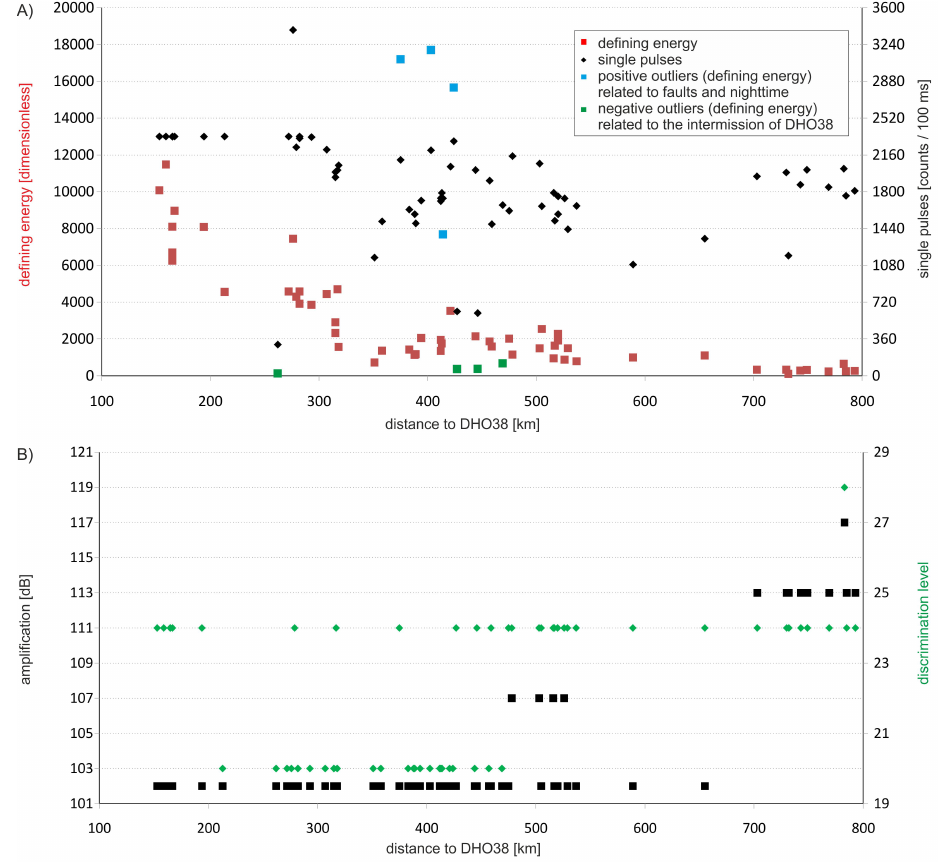
Fig. 5. (A) Maximum signal strength of horizontal measurements (cf. Fig. 3) as a function of distance to DHO38. The strength of the defining energy (red, blue, and green) is a function of the distance to DHO38, while the maximum number of single pulses in each measurement (black) is mostly constant and often coincides with the transmitting frequency of DHO38. (B) Device settings of the Cerescope for the measurements displayed in (A)